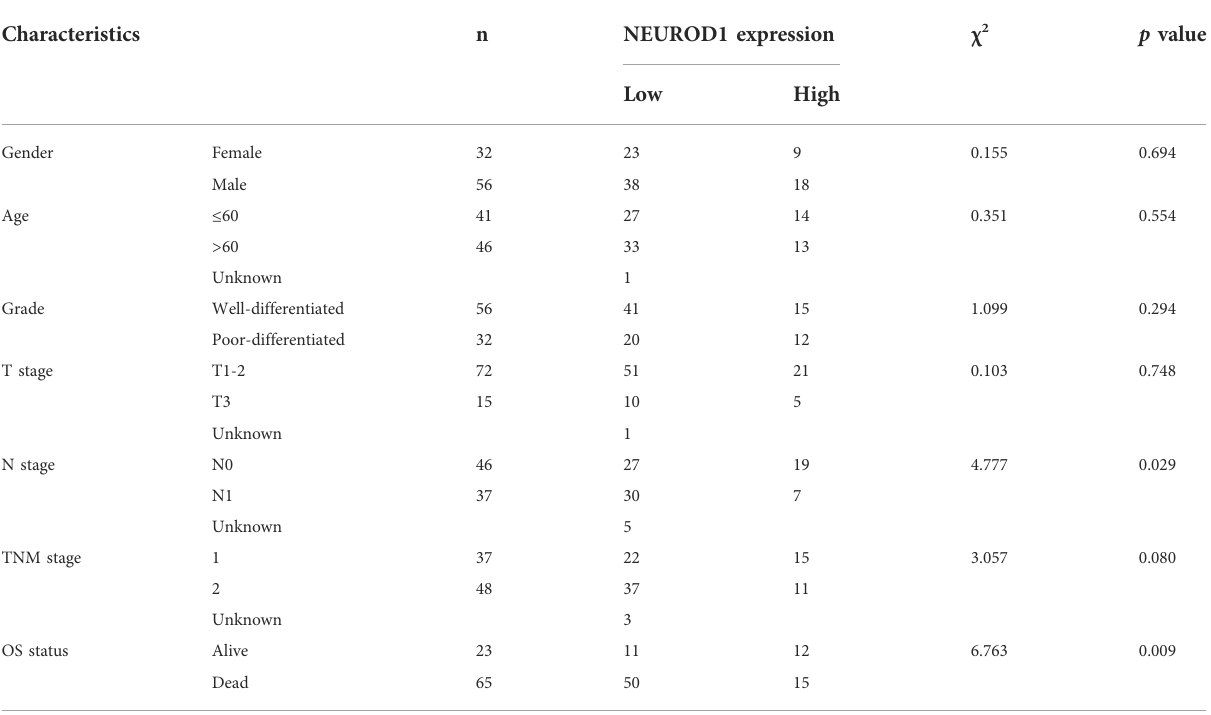
TABLE 4 Association between NEUROD1 expression and baseline characteristics in PaCa. Characteristics